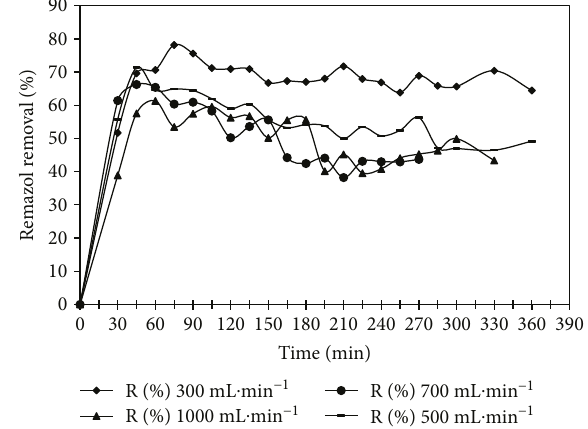
Figure 7: E ff ect of removal percentage rate on RYD initial concentration remazol 100mg · L − 1 : % RYD 300mL · min − 1 , % RYD 500mL · min − 1 , % RYD 700mL · min − 1 , and % RYD 1000mL · min − 1 .